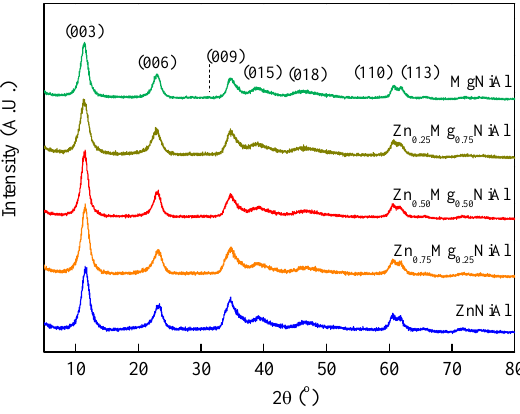
Figure 1. X ‐ ray diffraction (XRD) patterns of Zn x Mg 1– x NiAl layered double hydroxides (LDHs). Figure 1. X-ray diffraction (XRD) patterns of Zn x Mg 1 − x NiAl layered double hydroxides (LDHs).